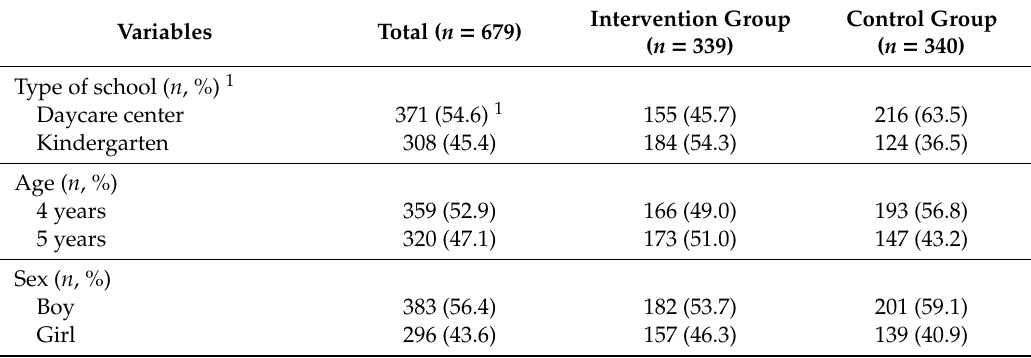
Table 1. Demographic characteristics of the intervention group (IG) and control group (CG).